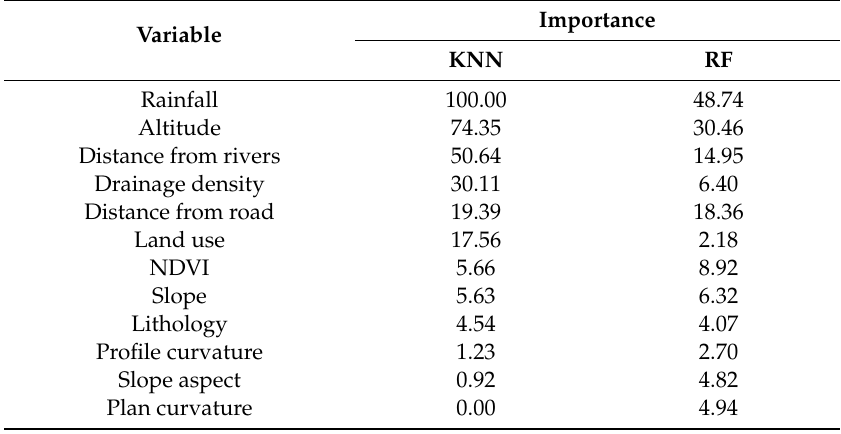
Table 2. Share of the gully erosion e ffi cacy variables to the KNN and RF methods.